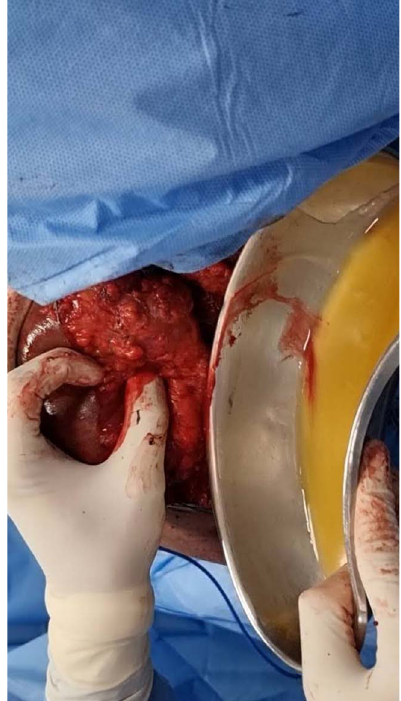
Figure 6. Straw yellow coloured pus drained